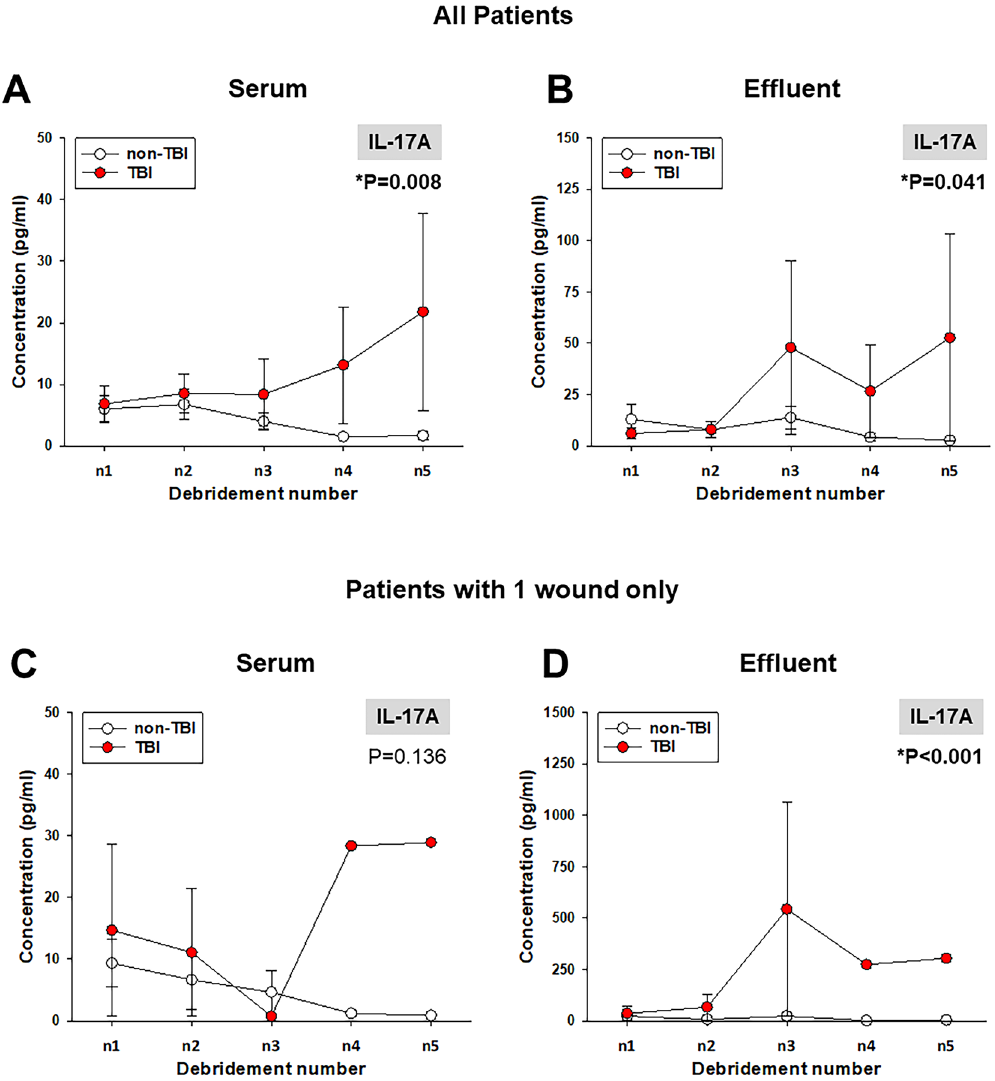
Figure 1. Levels of IL-17A in serum and wound effluent samples from TBI and non-TBI trauma patients. Inflammatory mediators in serum and wound effluent samples of trauma patients taken during five consecutive debridements were measured by Luminex™ as described in “Materials and methods”. Comparison of levels of IL-17A in both serum ( A ) and wound effluent ( B ) samples shows significant elevation in TBI vs. non-TBI patients. Comparison of levels of IL-17A in serum ( C ) and wound effluent ( D ) samples of patients with 1 wound only as described in Results (*P < 0.05, analyzed by Two-Way ANOVA as described in “Materials and